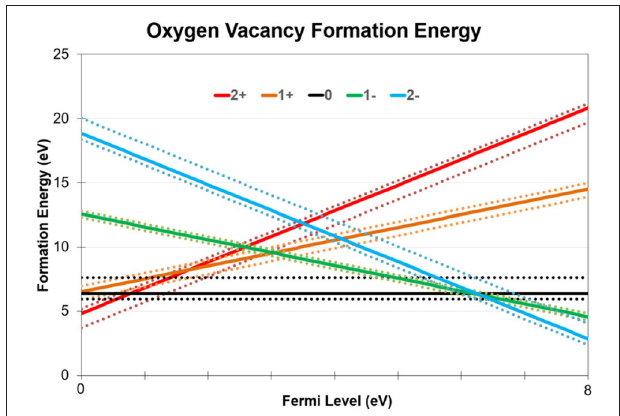
FIGURE 7 | O vacancy formation energies in a-SiO 2 at various charge states as a function of Fermi level. 144 vacancy geometries were calculated for each charge state due to the amorphous nature of our material. The average formation energy of each charge state is plotted using solid lines, while the minimum and maximum values for each charge state is plotted using dotted lines. The crossing point between positive and neutral vacancies is shown to be between 0.5 and 1.0 eV while the crossing point between neutral and negatively charged vacancies is between to be 6.2–7.5 eV.